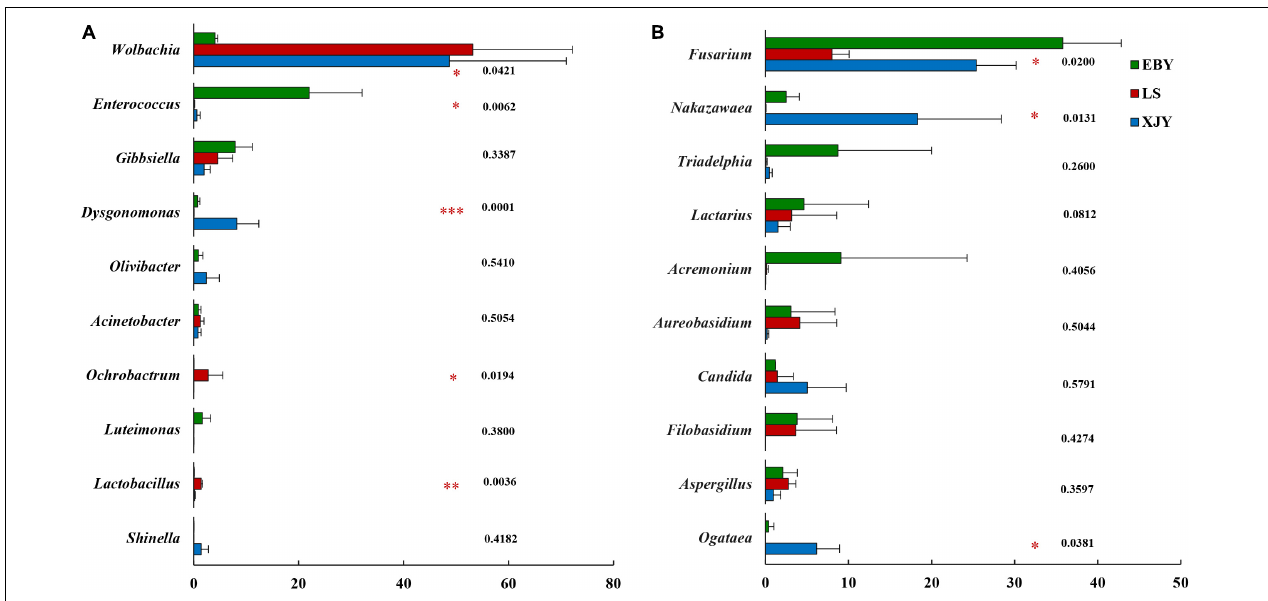
FIGURE 6 | Significant differences in microbial composition in the larval gut following feeding on three host tree species. Differences in relative abundance are shown for the ten most significant differences. Relative abundances are shown for (A) bacteria and (B) fungi. EBY, Populus gansuensis ; LS, Salix babylonica ; XJY, Populus alba var. pyramidalis . One-way ANOVA followed by Scheffe test; ∗ 0.01 < p ≤ 0.05, ∗∗ 0.001 < p ≤ 0.01, ∗∗∗ p ≤